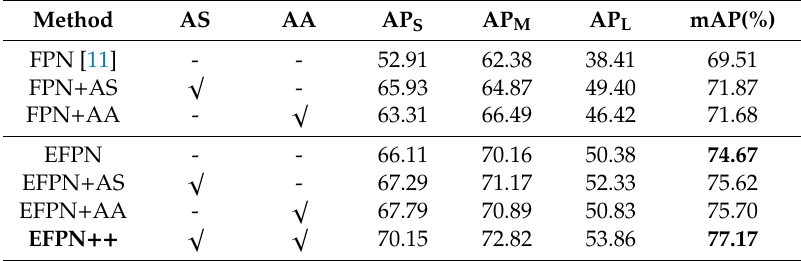
Table 4. The results of comparison for using the adaptive scale training strategy and anchors on the DOTA-v1.5 validation dataset. EFPN: Extended Feature Pyramid Network. AS: adaptive scale training strategy. AA: adaptive anchors. EFPN ++ : EFPN with the adaptive scale training strategy and the adaptive anchors.